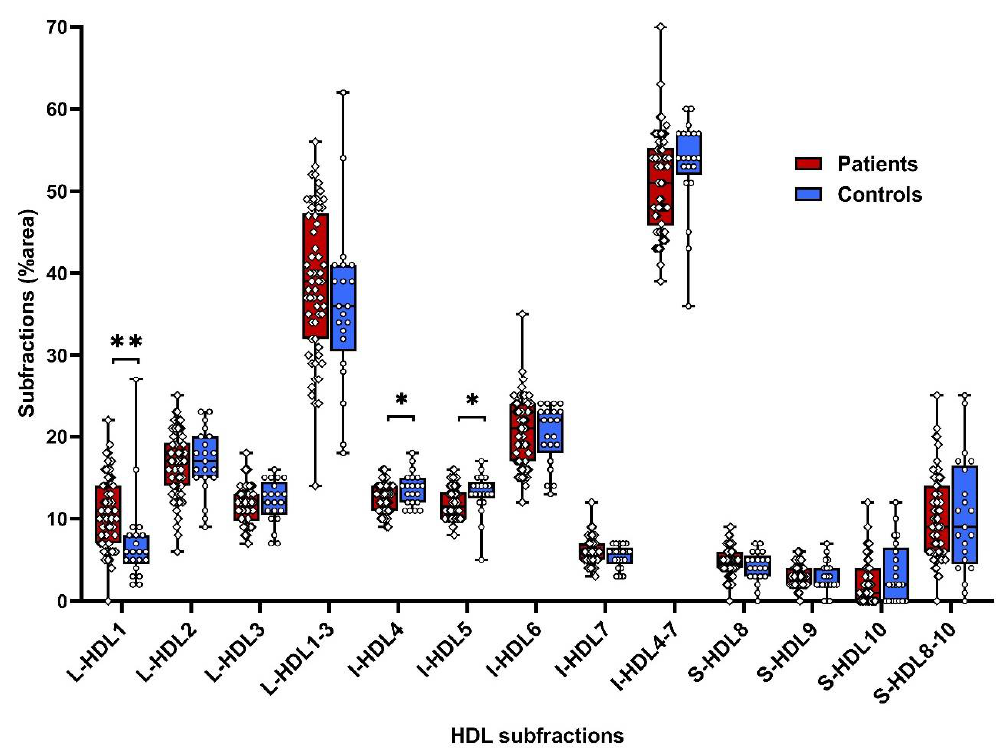
Figure 4. HDL subfractions in controls and patients at the baseline. HDL—high density lipoprotein, L-HDL—large HDL subfraction, I-HDL—intermediate HDL subfraction, S-HDL—small HDL subfraction, * p < 0.05, ** p < 0.01.